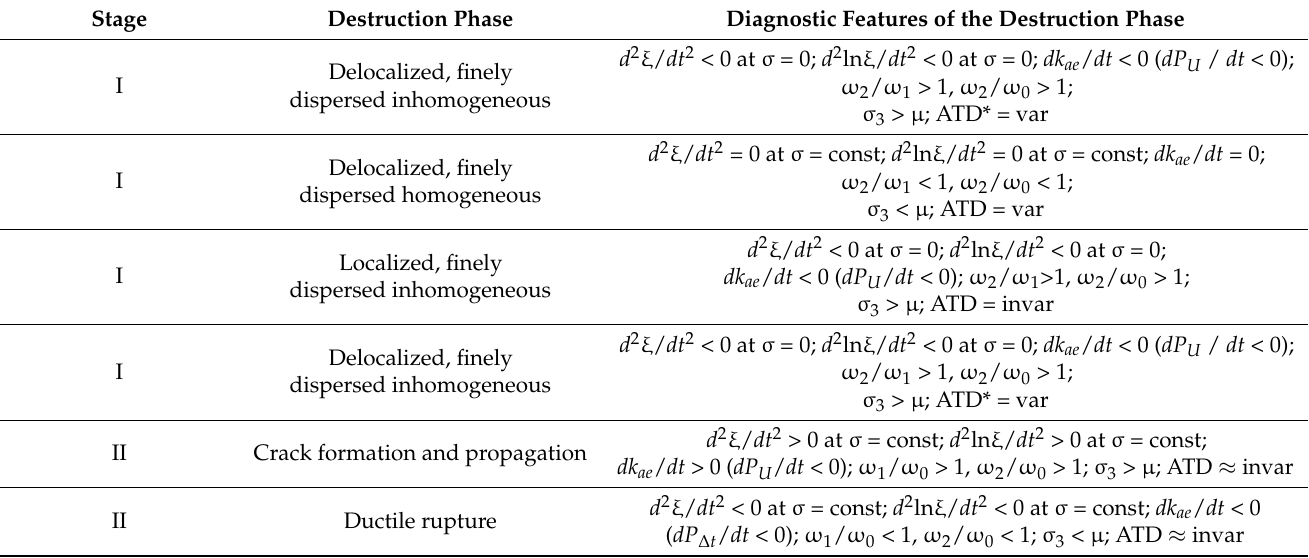
Table 1. Diagnostic features of destruction phases and service life appraisal